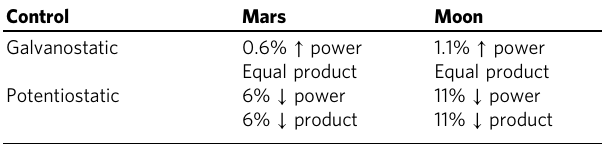
Table 1 Practical implication of low gravity